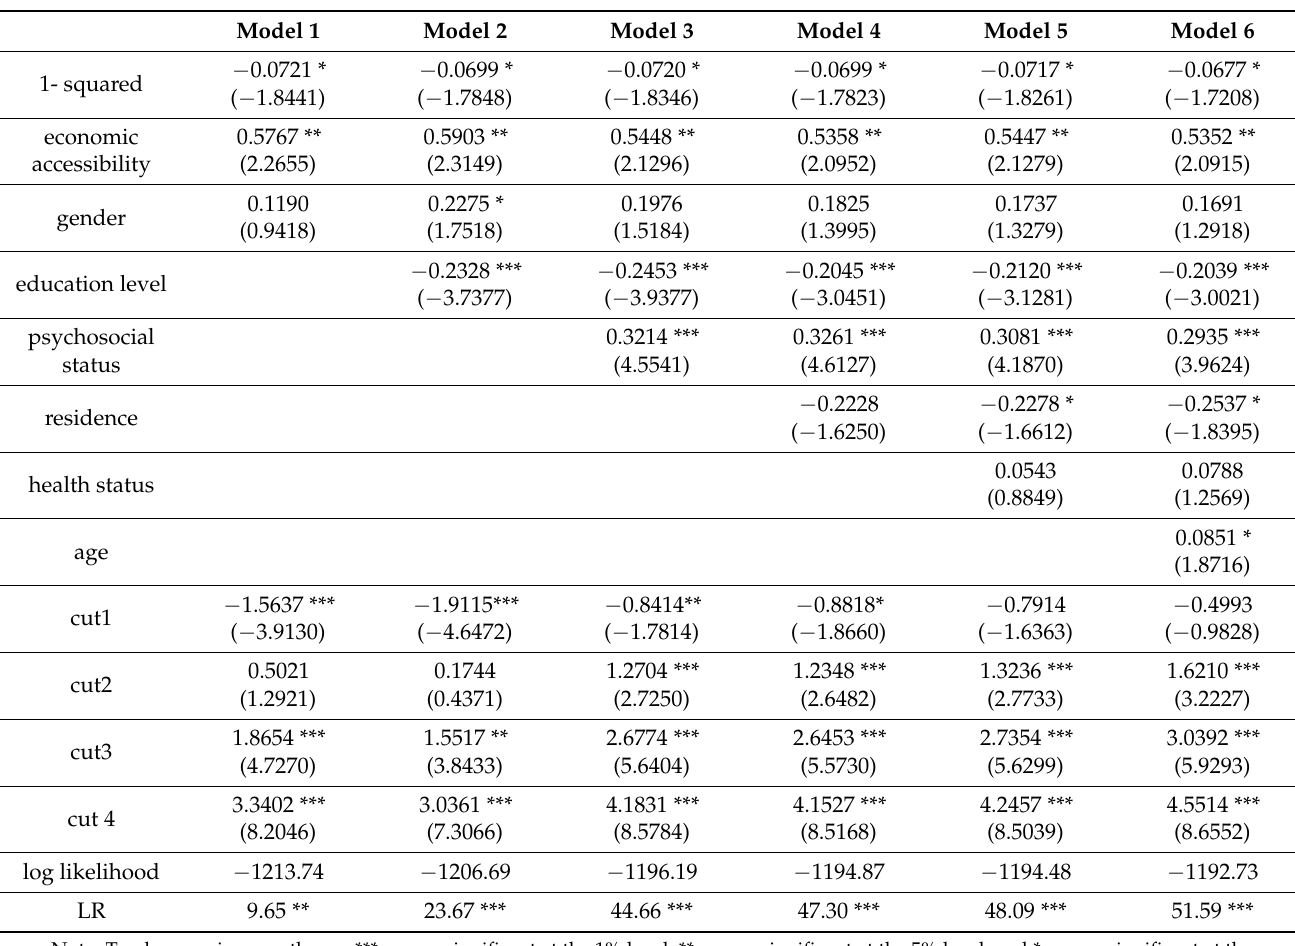
Table 2. Impact of economic accessibility on realized